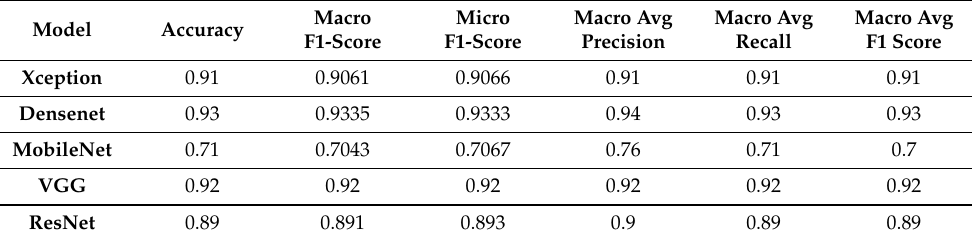
Table 7. Summary of results for feline reticulocyte dataset.